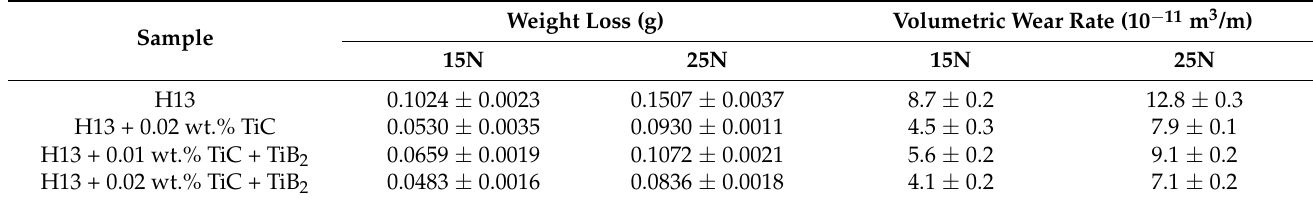
Figure 6. Volumetric wear rate of H13 steel without and with different types and contents of nanoparticles under sandpaper with abrasive particle size of 28 µ m and different loads.